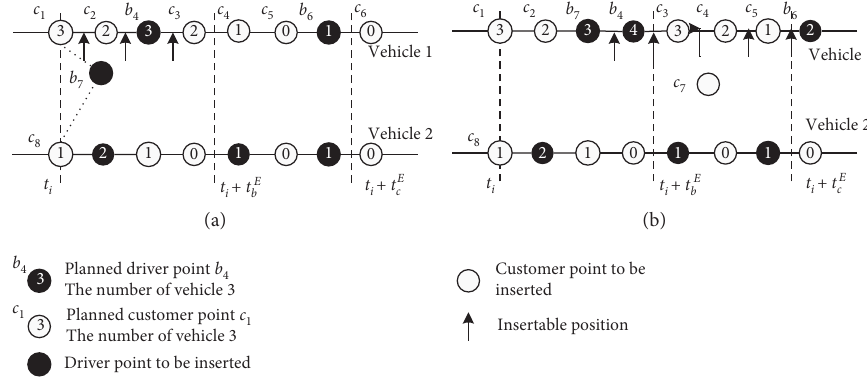
Figure 4: Neighborhood